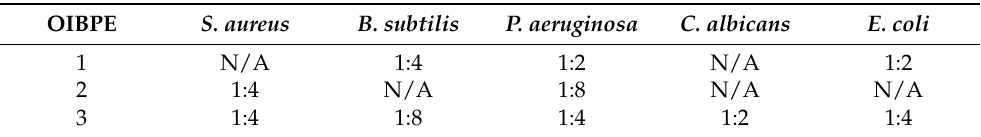
Table 5. MIC results represented by dilutions of the extracts.